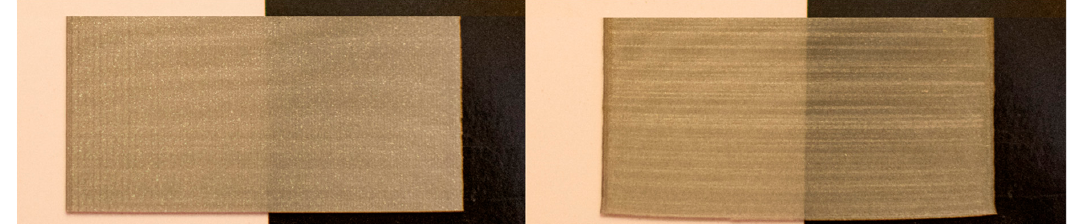
Figure 8. Narrow thickness samples printed with PLA filaments (left) and ABS filaments (right).